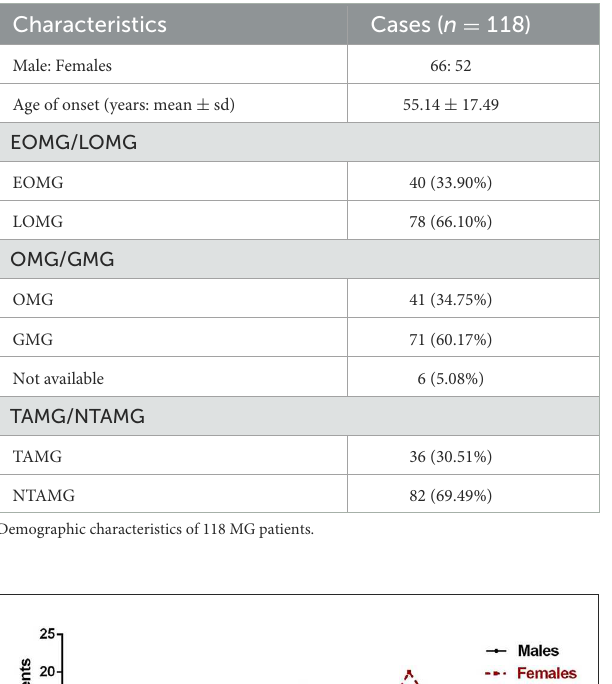
TABLE 1 Demographic characteristics of MG patients.